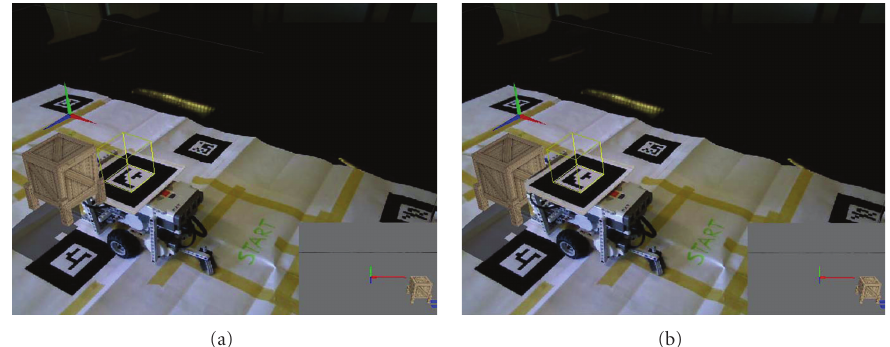
Figure 4: The same view of the real forklift and virtual crates with no occlusion and with dark matter based occlusion turned